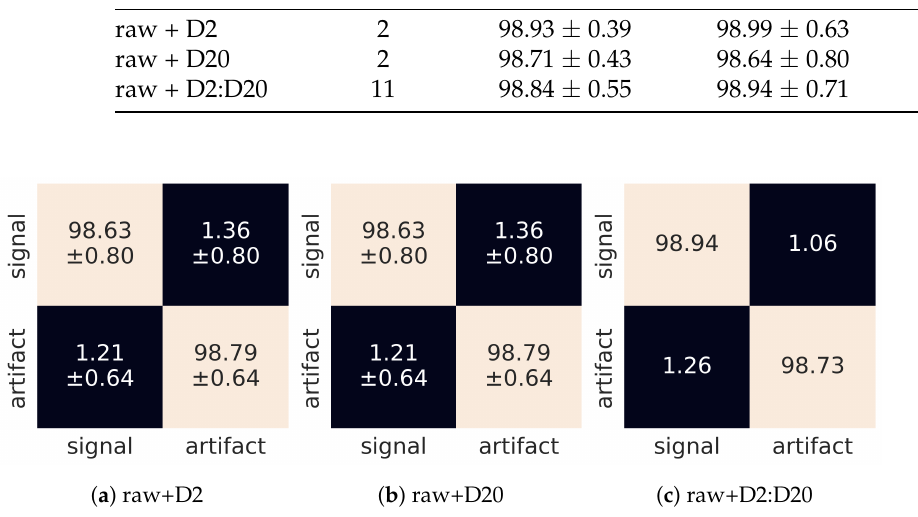
Figure 13. Confusion matrices for different dimensions of the input tensors: ( a ) composition of the raw image and single D2 wavelet, ( b ) composition of the raw image and single D20 wavelet, ( c ) composition of the raw image and collection of [D2, D4, ..., D20] wavelets. The horizontal and vertical dimensions refer to predicted and judged labels, respectively. Figure 14 indicates that similarly as in previous two cases the CNN learning curves for the combined input stabilise around 20th epoch.